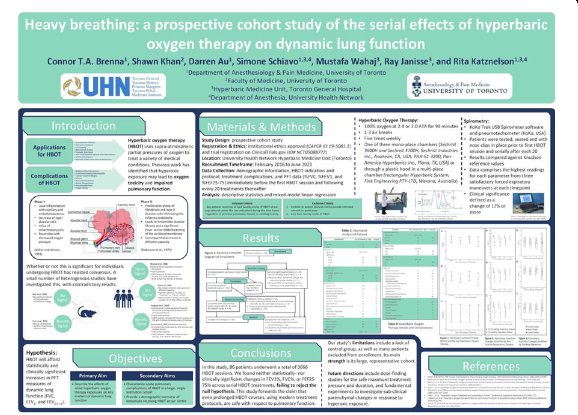
Fig. 1 (abstract A91). See text for